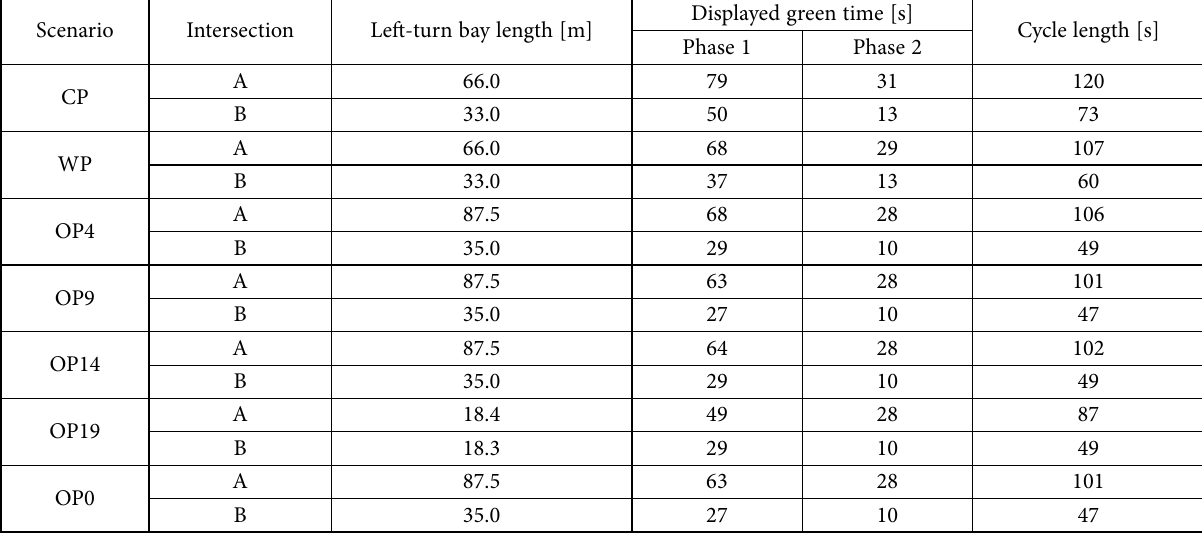
Table 5. Left-turn bay length and signal timing parameters for seven simulation scenarios Scenario